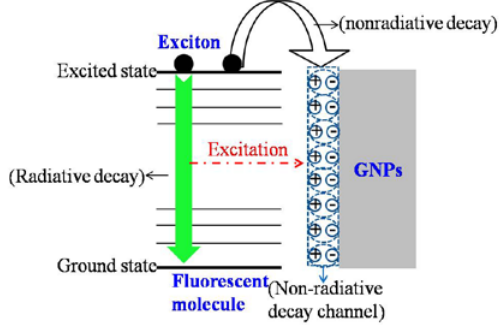
Figure 6. Schematic diagram of nonradiative decay process.